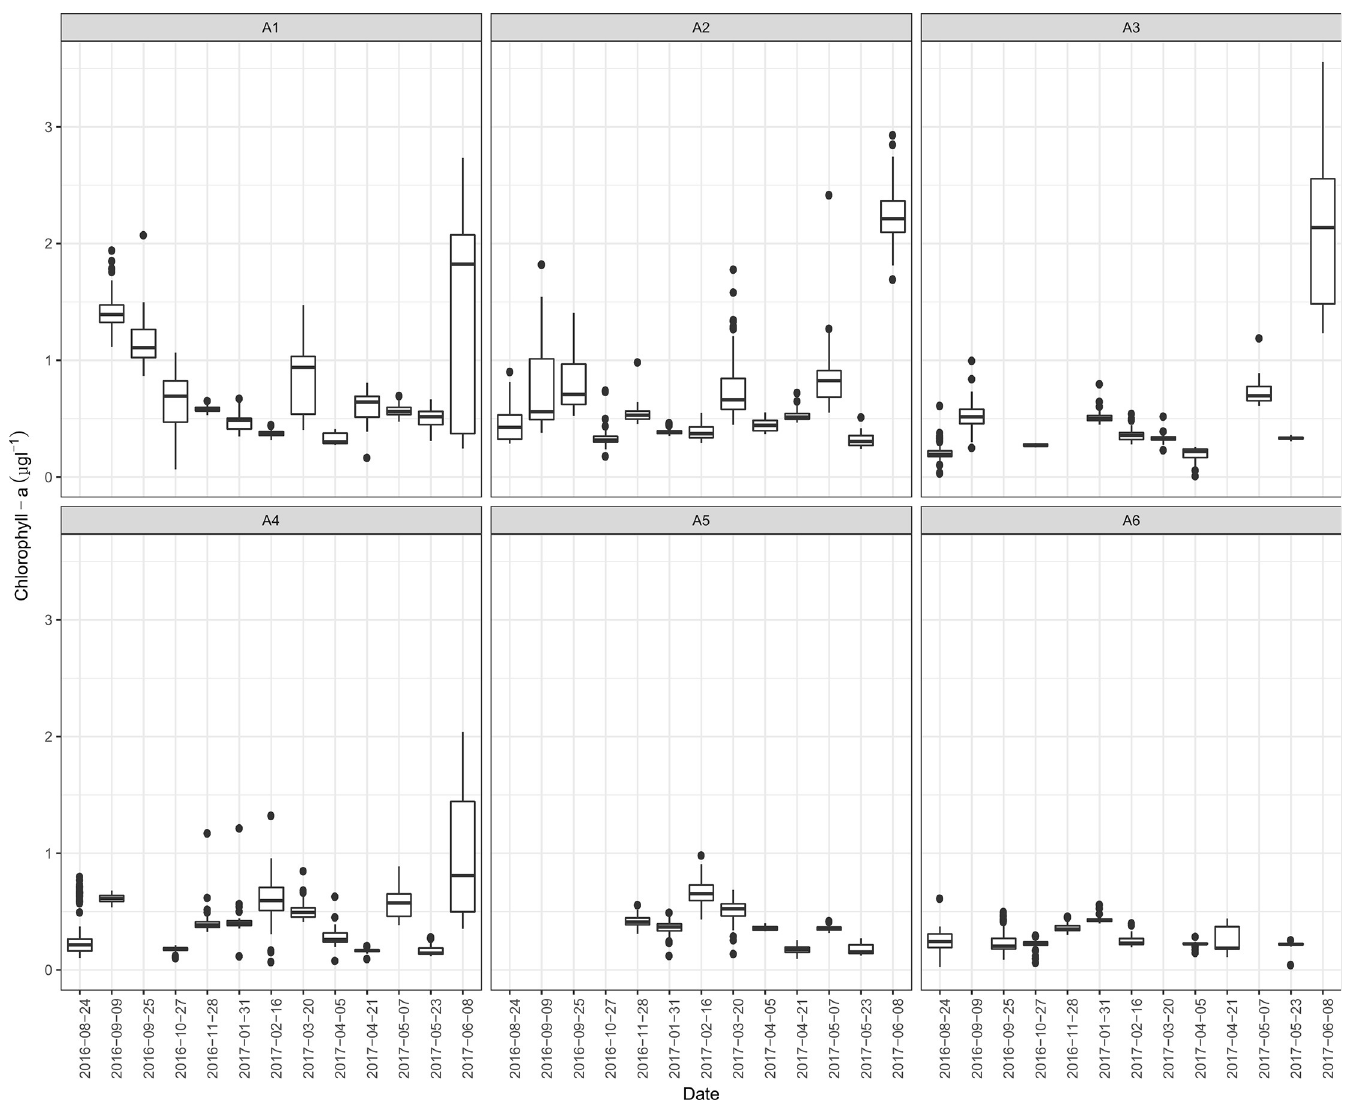
Fig 2. Observed chlorophyll-a values during the survey period. Solid lines represent medians; boxes the interquartile ranges; whiskers minimum and maximum or 1.5 times the interquartile range (when outliers were present); points represent the outliers. A1-A6 arbitrary areas (see Fig 1 for details).